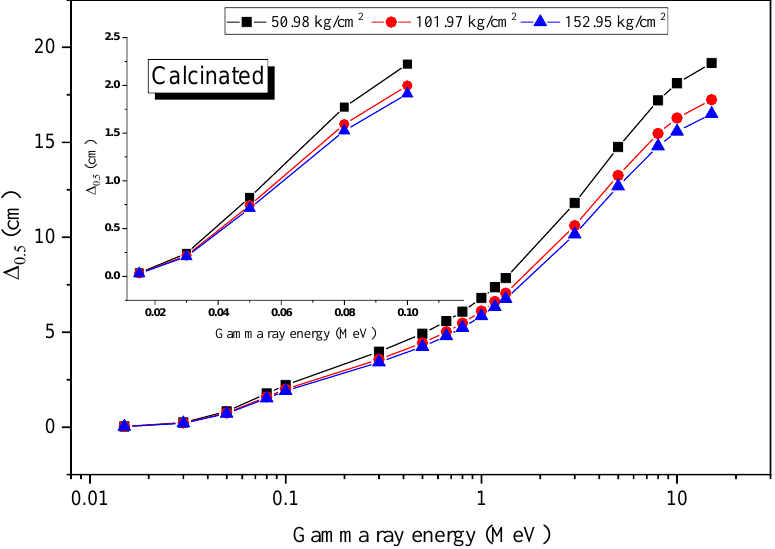
Figure 10. Variation in the Δ 0.5 versus the gamma-ray energy for the calcinated bentonite. The variation in Δ 0.5 versus the pressure rate for both samples is graphed in Figure 11 . It is clear that the thinner Δ 0.5 achieved for the ball-milled calcinated bentonite where